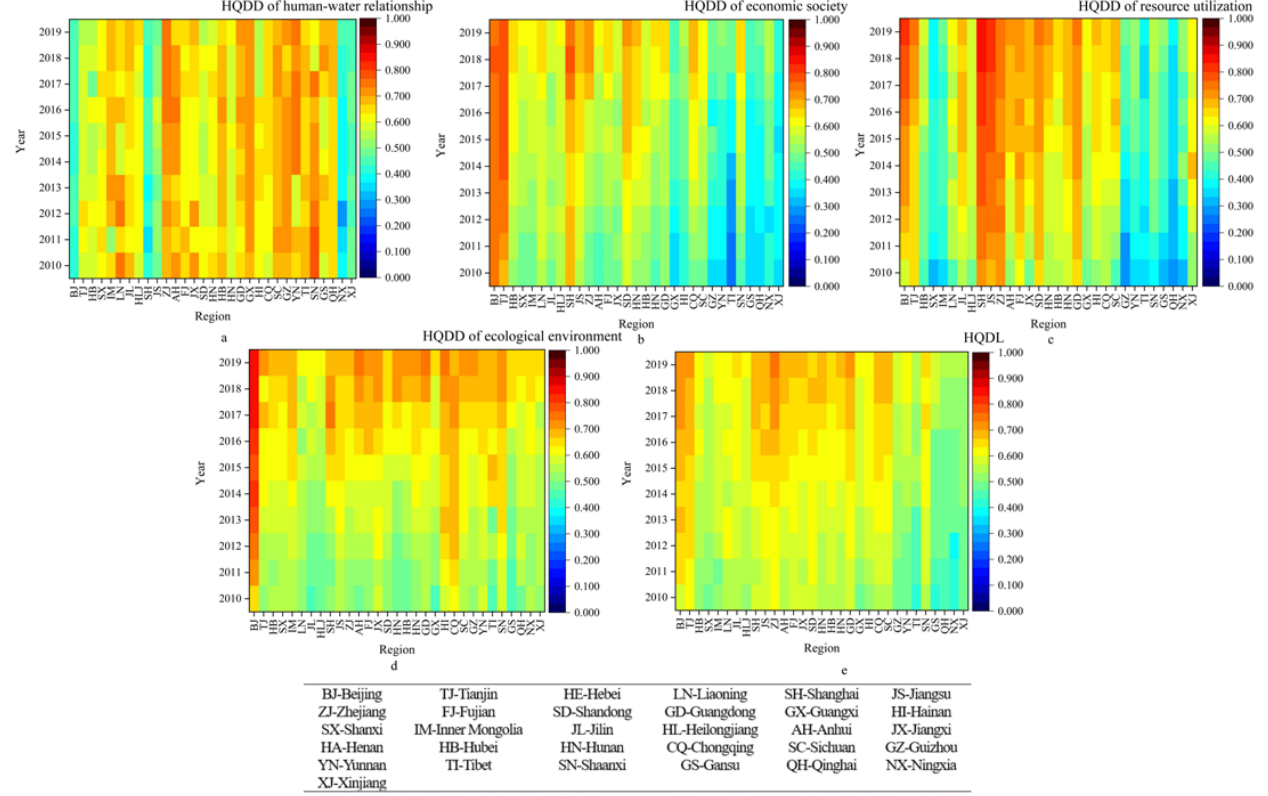
Figure 10. Comparison of HQDD of four subsystem and HQDL from 2010 to 2019 ( a – d ) are HQDD of the human-water relationship subsystem, economic social subsystem, resource utilization subsystem and ecological environment subsystem, and ( e ) is HQDL.